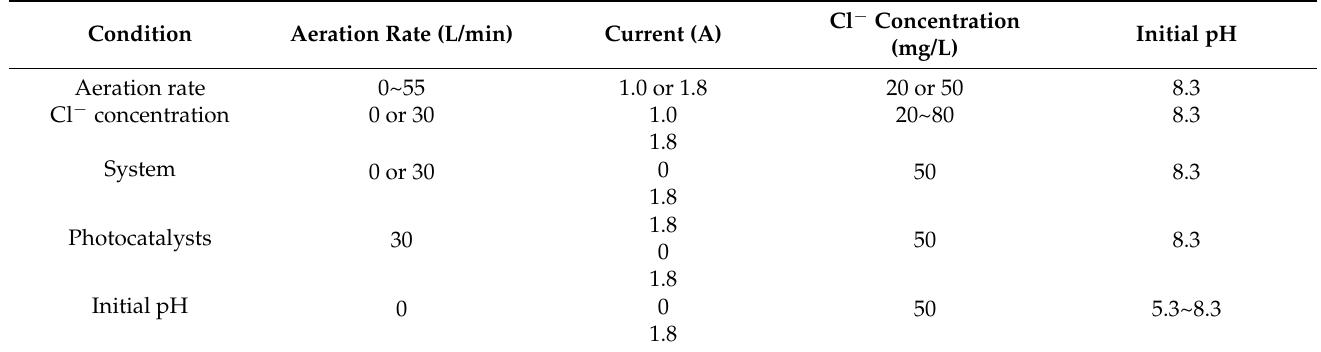
Table 4. Experimental